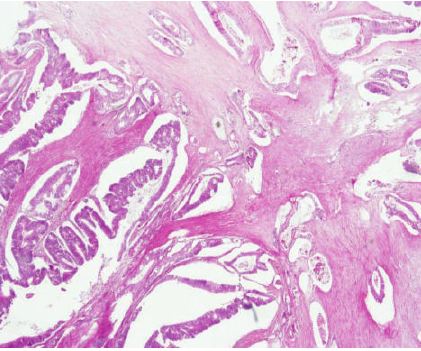
Figure 2: Adenocarcinoma in sigmoid